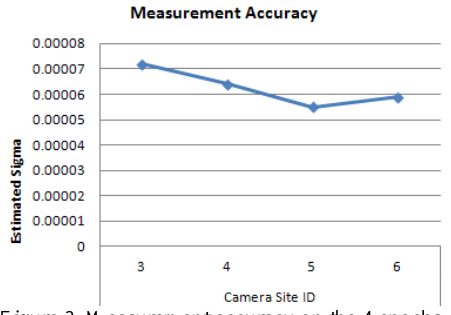
Figure 3. Measurement accuracy on the 4 epochs